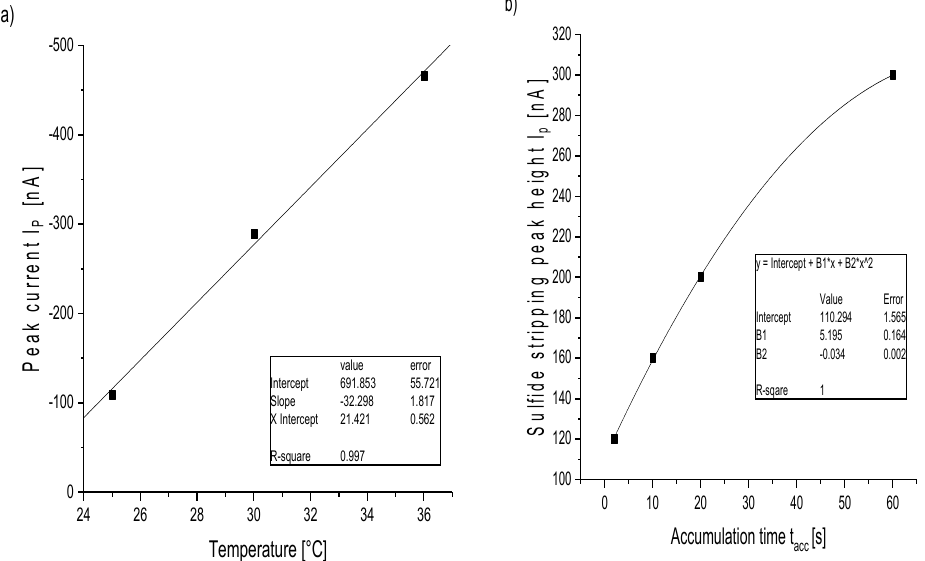
Figure 2. Stripping peak current I p effected by ( a ) temperature and ( b ) by accumulation time t acc . AWW 1 with 25 - µM sulfide.